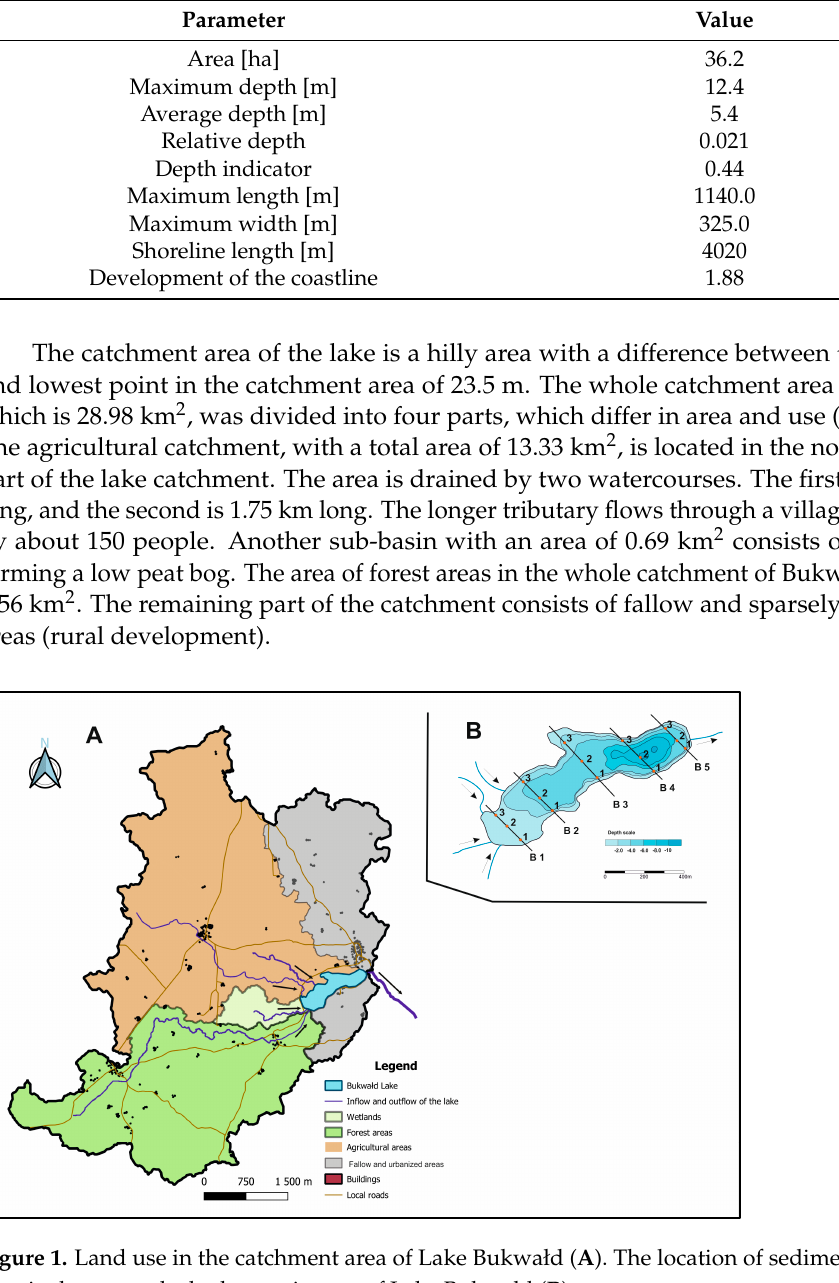
Table 1. Morphometric indicators of Bukwałd Lake.